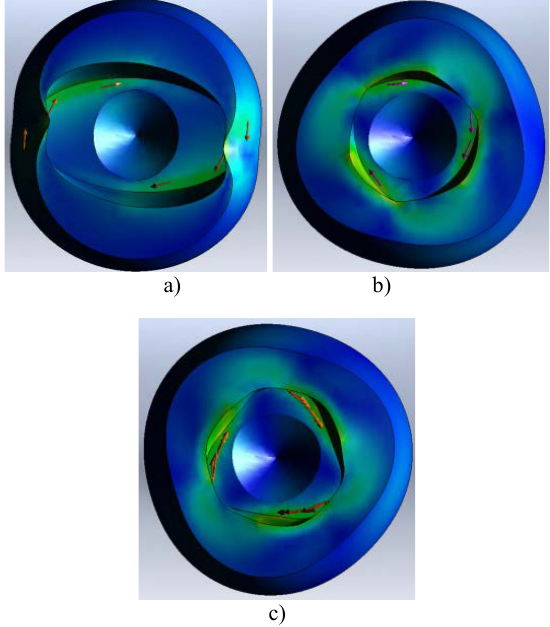
Fig. 4. The result of modeling with the use of various special profiles. a) ellipse; b) Ryolo's triangle; c) rounded triangle As a r esult o f th e s imulation o f s pecial p rofiles, rational were such profiles as the Ryolo's triangle and the rounded t riangle. T he maximum stress values for t hese profiles are within σ = 1249.64-1309.46